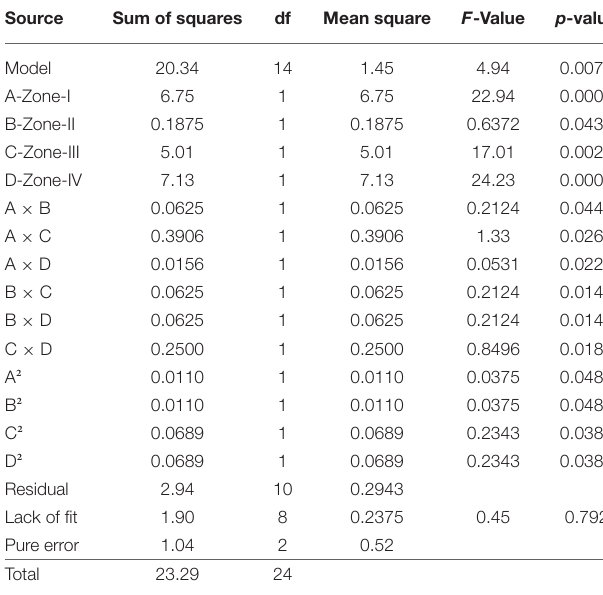
TABLE 7 | Analysis of variance for the prevalence of C. perfringens toxinotypes in four different zones of Punjab province in Pakistan.